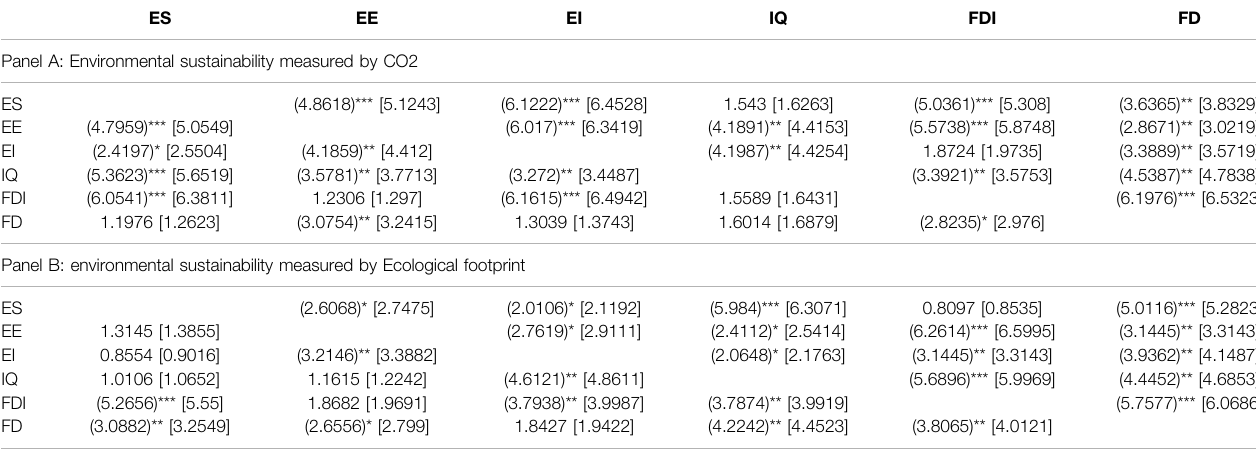
TABLE 8 | Results of causality test: EI measured by the total number of patent. ES EE EI IQ FDI FD Panel A: Environmental sustainability measured by